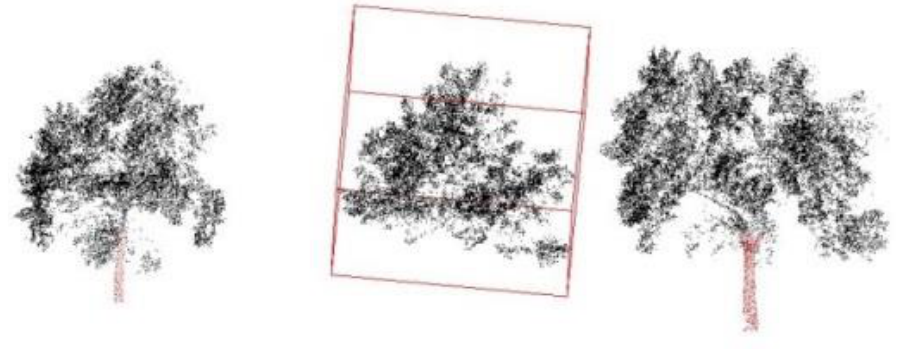
Figure 18. Extraction results of poplar tree without